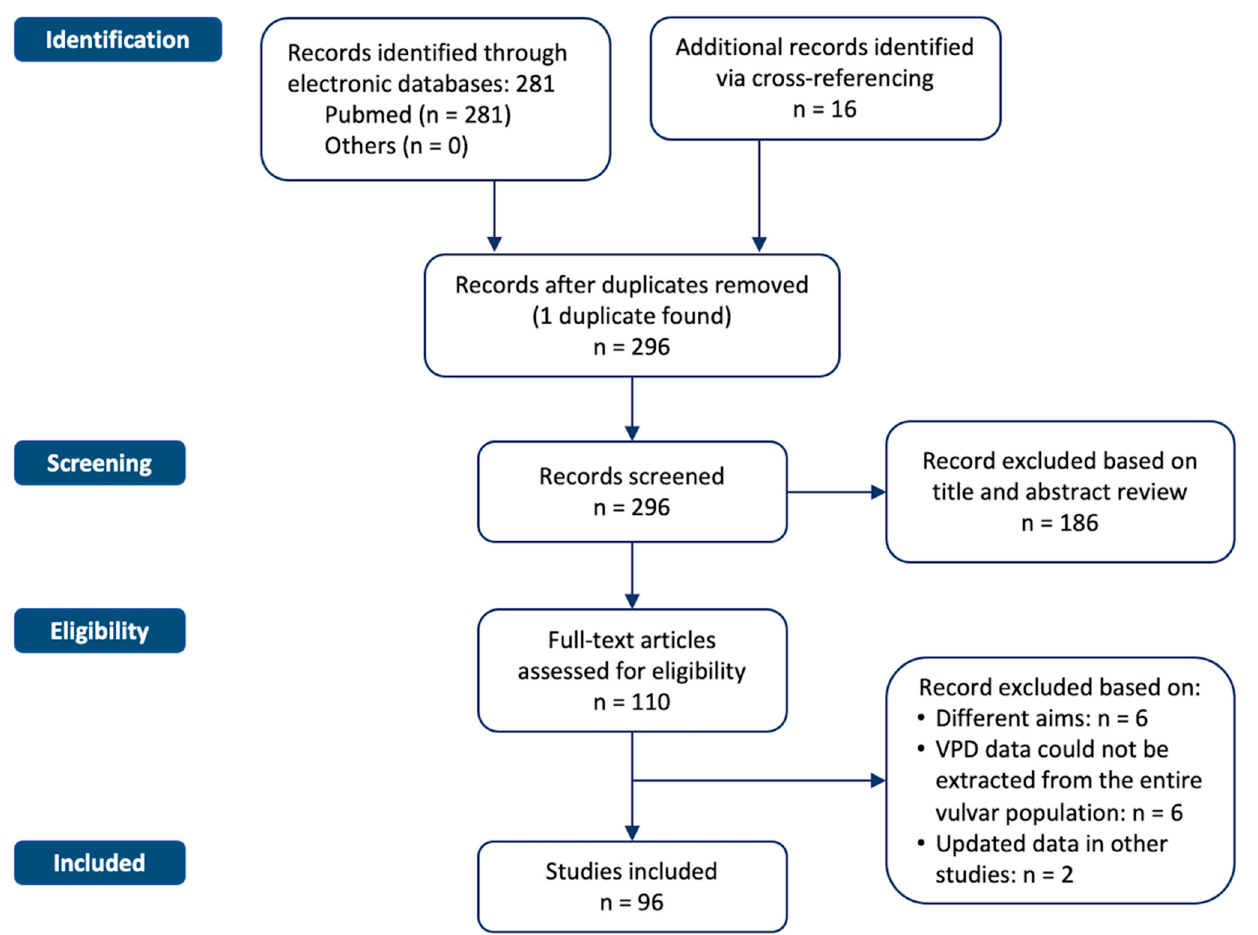
Figure 1. Flowchart of the systematic literature search process. The study selection resulted in a total of 281 relevant articles.